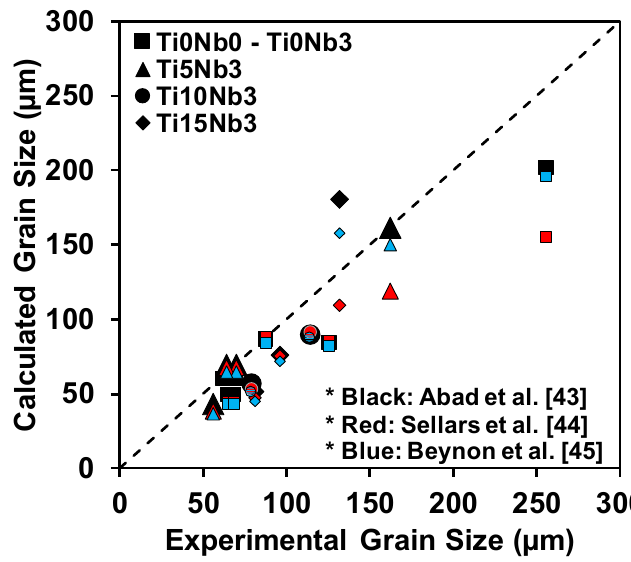
Figure 17. Comparison between the experimental recrystallized grain size measured for the steels investigated and predictions from several models proposed in the literature [43–45].